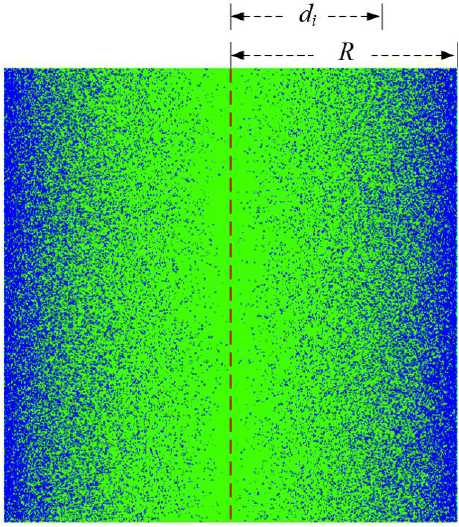
Figure 1. Schematic view of the model (the blue dots represent activated weakening contacts and the green dots represent normal contacts.).